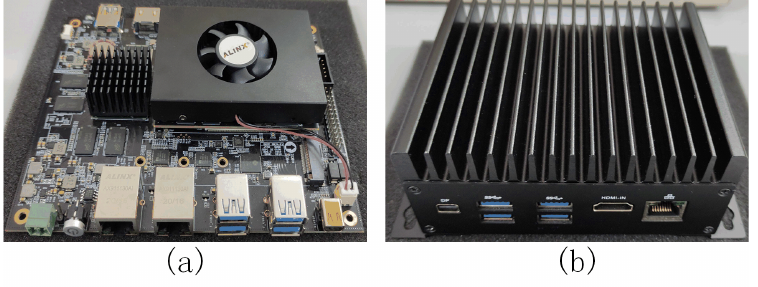
Figure 4. Industrial embedded platform. ( a ) is a industrial embedded platform for debugging, ( b ) is a industrial embedded platform for industrial